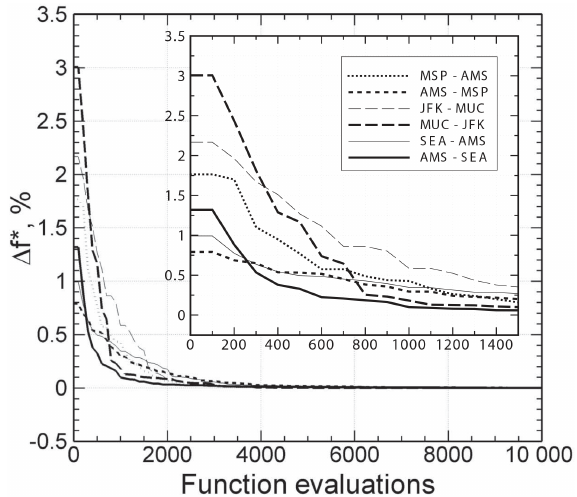
Figure 16. Flight time (in %) vs. number of function evaluations ( = n p × n g ) for three selected airport pairs, including the enlarged drawing in the early 1500 evaluations. The population size n p is 100 and the number of generations n g is 100. (cid:49)f ∗ means the difference in flight time between the solution f and the obtained optimal solu- tion f opt , which was finally obtained after 10000 function evalua- tions. This was chosen because f true for the six flights are unknown. The f opt for each flight corresponds to the flight time for the time- optimal case (column 7, Table 8). The (cid:49)f ∗ (in%) is calculated as ((cid:49)f ∗ /f opt ) ×